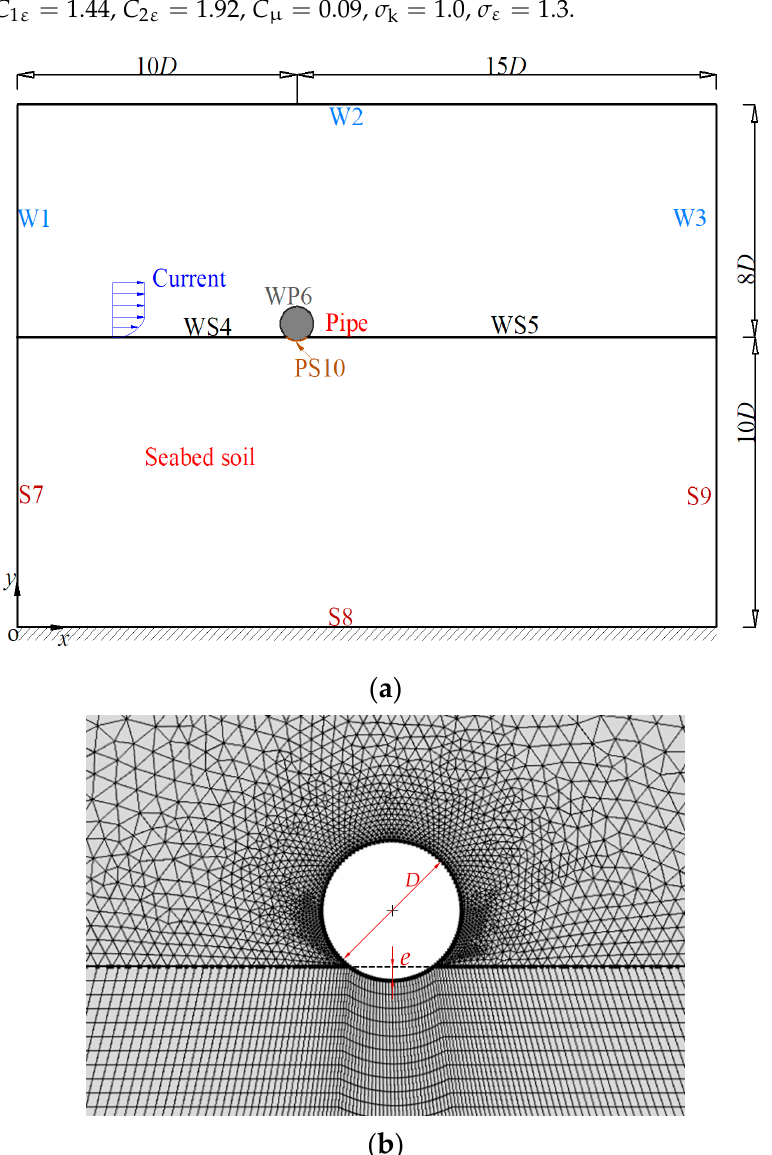
Figure 2. ( a ) Geometry of the FE model; ( b ) computational meshes in the proximity of the pipe.